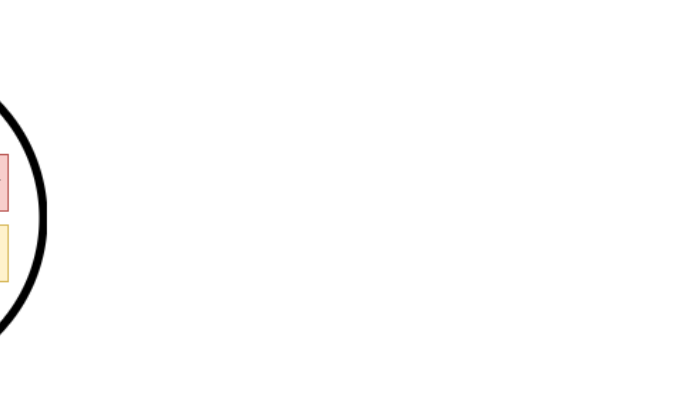
Figure 36. PipeProbe sensor capsule consisting of a waterproof plastic casing, a flow velocity stabiliser, Eco mote, a pressure sensor, a gyroscope sensor and a counterweight. Adapted from [28].